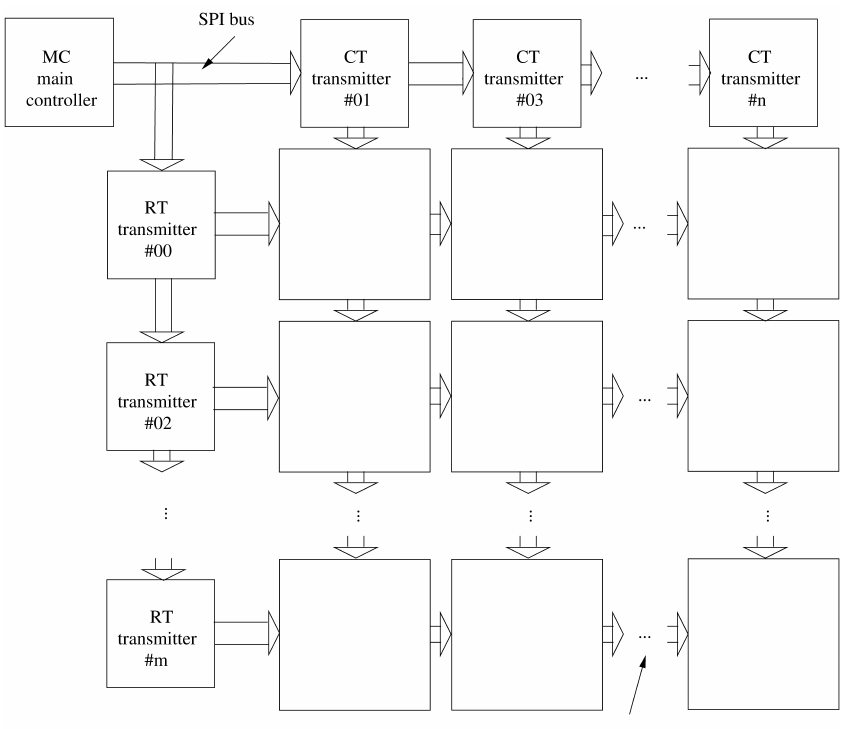
Figure 6. Block diagram of the proposed system. The white squares represent the tiles. The Main controller controls via SPI the RT and CT modules, which generate and buffer the suitable signals for the row and column lines of the tiles. These signals are propagated along the tiles, horizontally and vertically, using suitable connections placed on the back of each tile.